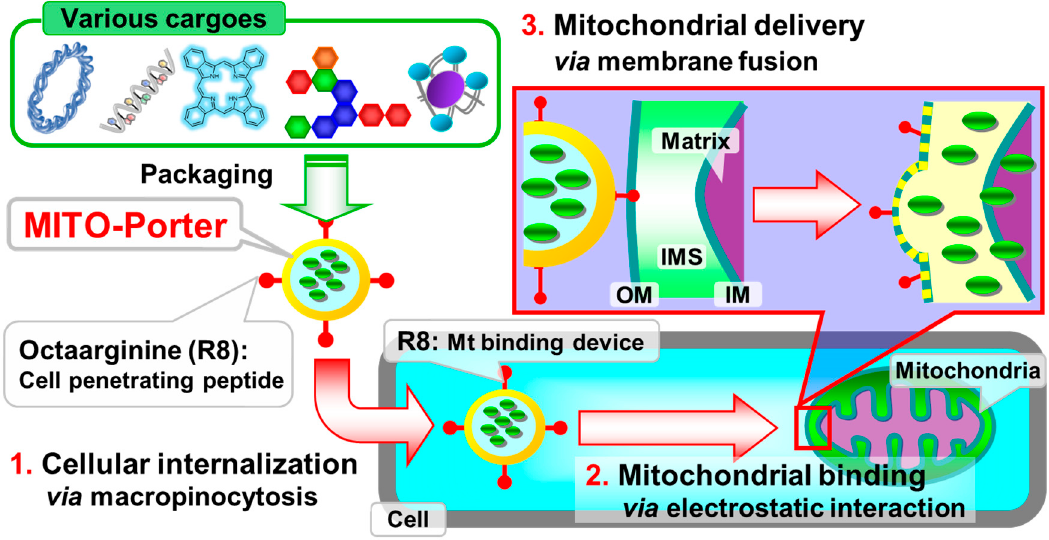
Figure 2. Schematic image of the use of a MITO-Porter for mitochondrial delivery. The MITO-Porter is efficiently internalized via macropinocytosis as the initial step. The second step is the interaction of the MITO-Porter with the mitochondrial membrane. Finally, the cargoes are delivered into mitochondria via membrane fusion. IM, inner membrane; IMS, intermembrane space; outer membrane.